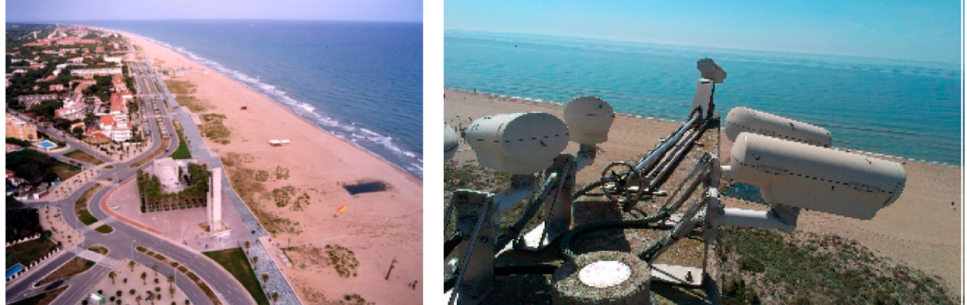
Figure 1. Video monitoring system of Castelldefels beach (Barcelona, Spain).